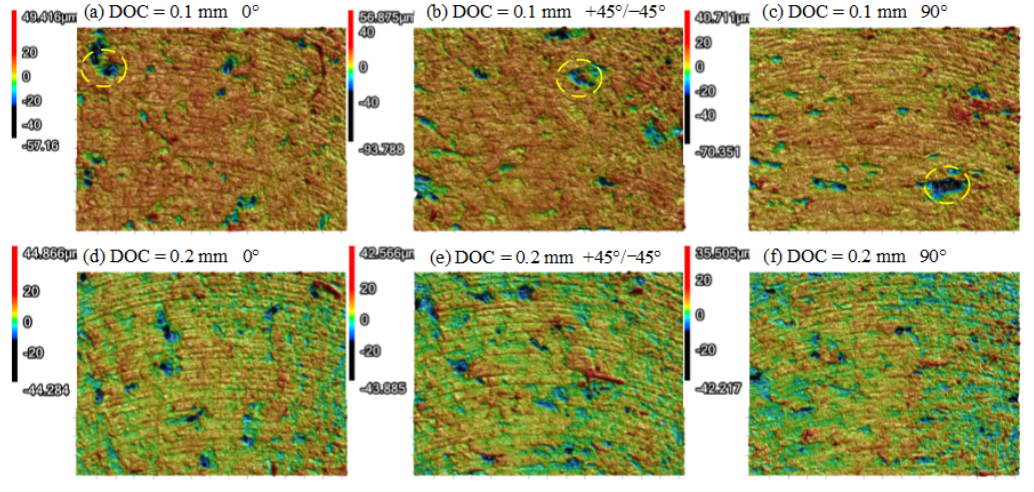
Figure 7. 3D morphologies of milled CF/PEEK parts under different RAs: ( a ) DOC = 0.1 mm, RA = 0 ° ; ( b ) DOC = 0.1 mm, RA = +45 ° / − 45 ° ; ( c ) DOC = 0.1 mm, RA = 90 ° ; ( d ) DOC = 0.2 mm, RA = 0 ° ; ( e ) DOC = 0.2 mm, RA = +45 ° / − 45 ° ; ( f ) DOC = 0.2mm, RA = 90 ° .